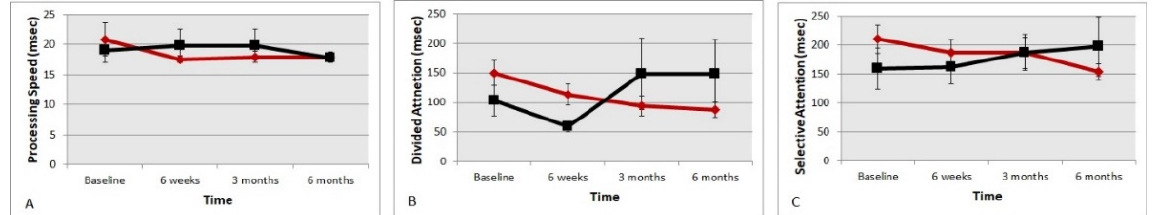
Figure 4. ( A – C ) Changes in reaction times seen in processing speed, divided attention and selective attention using the brain IQ useful field of view (UFOV). The red diamond symbols represent the treatment group and black square symbols represent the placebo group.